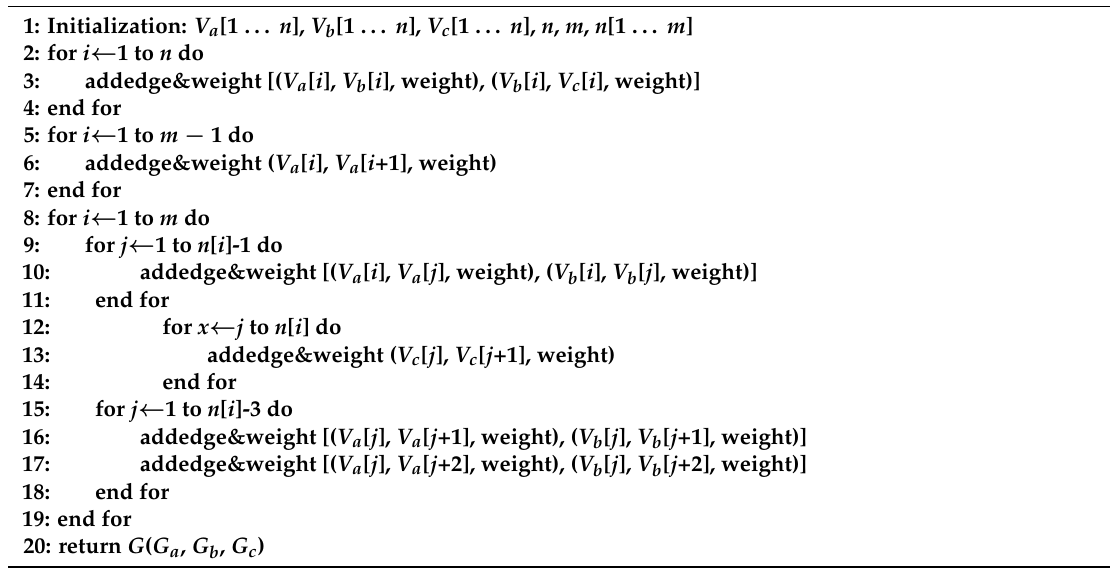
Table 2. Modeling algorithm for Structure 2. Algorithm 2: Modeling Algorithm for the Control Structure of Leader-Follower